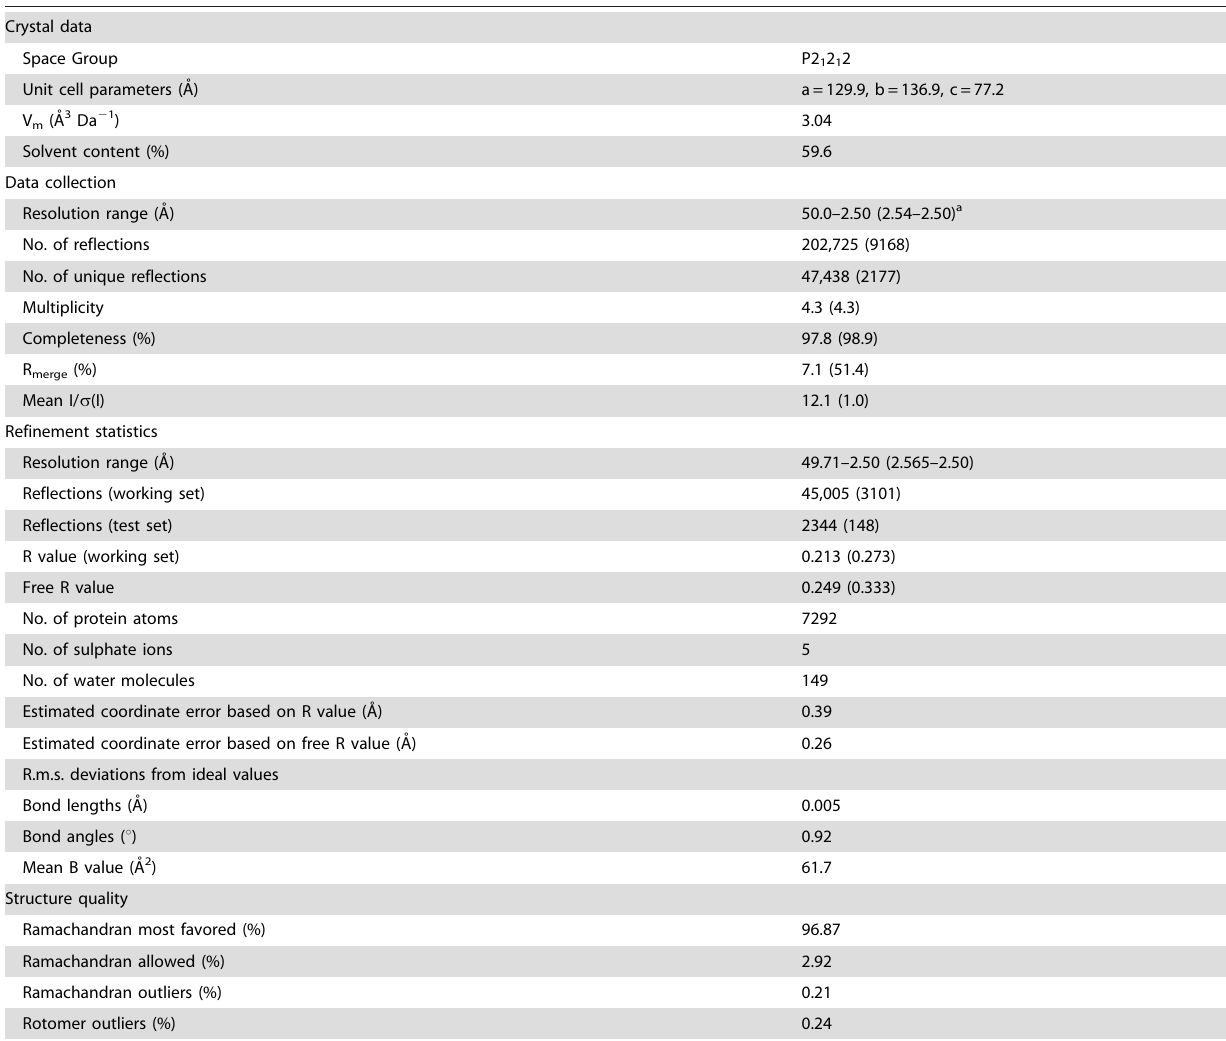
Table 1. Data-collection and refinement